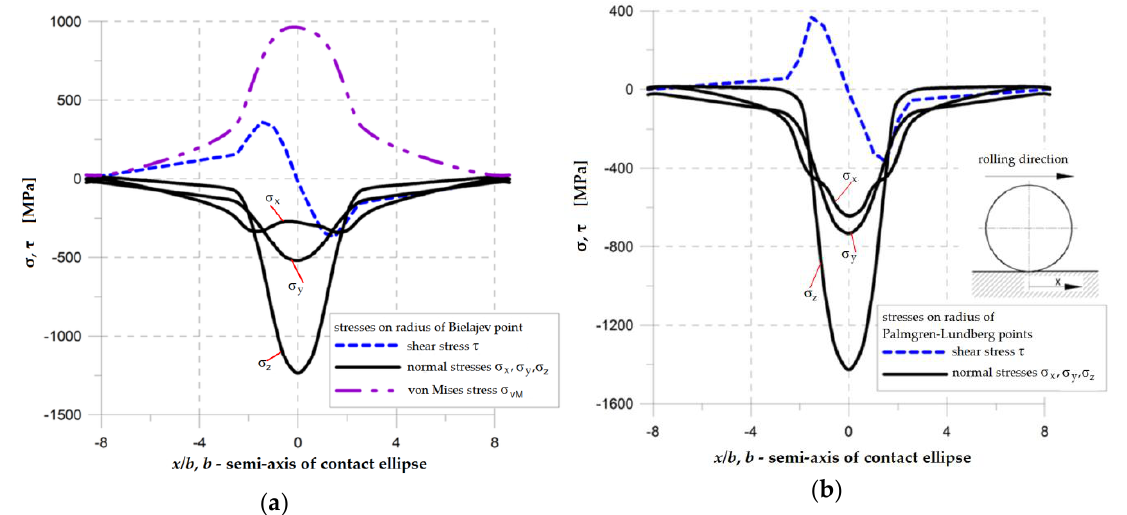
Figure 2. Distributions of normal and shear subsurface stresses for rolling bearing 6204* (loading Q max = 153 N, f = 0.544, f is defined in Equation (5)) ( a ) on radius corresponding to Bielajev point; ( b ) on radius corresponding to P-L points.